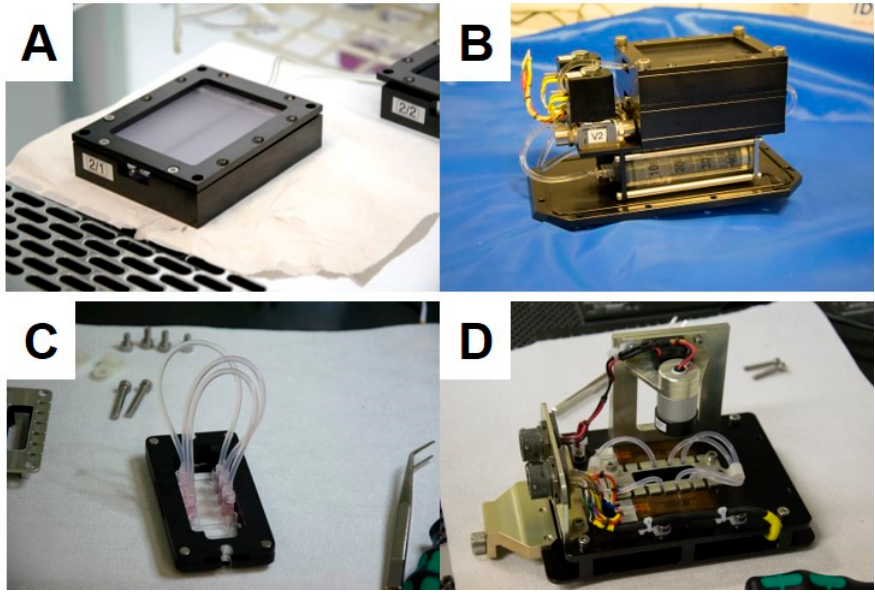
Figure 13. Late access units of the FLUFIX ( A , B ) and FLUMIAS ( C , D ).